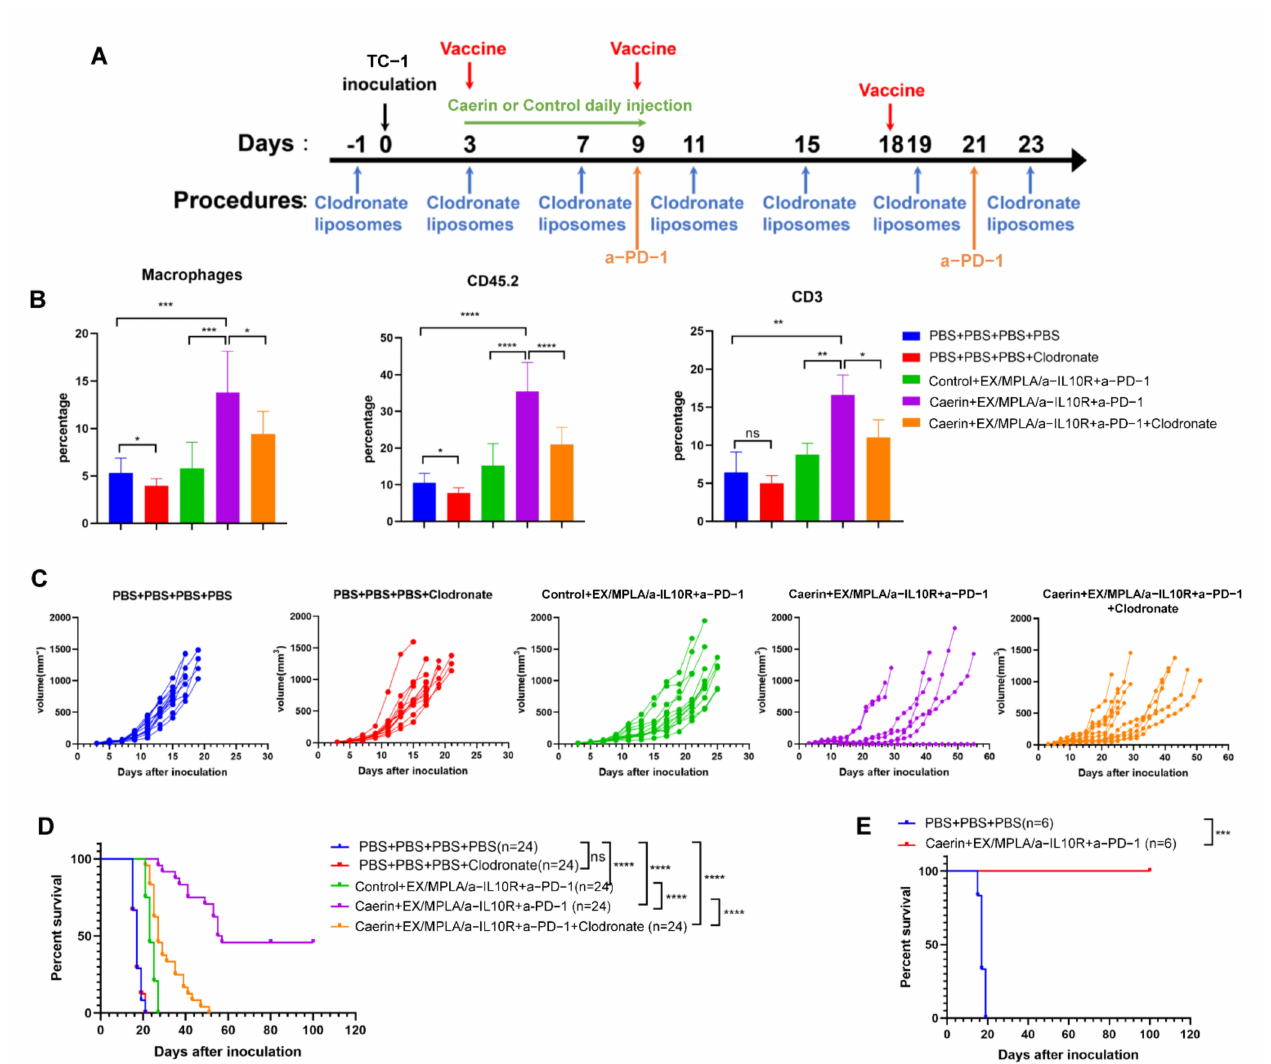
Figure 2. Depletion of macrophages impacts DT with caerin 1.1/1.9. ( A ) Timeline of immunotherapy and macrophage depletion. ( B ) Tumour infiltrating macrophages (CD45+CD11b+F4/80+), CD45+ and CD3+ T cells for the different treatment groups. ( C ) Tumour volume growth curves by treatment; each curve represents one individual. ( D ) Survival curves in different groups ( n = 24). (ns: non-significant, *: p < 0.05, **: p < 0.01, ***: p < 0.001 and ****: p < 0.0001). ( E ) Survival curves for mice that cleared